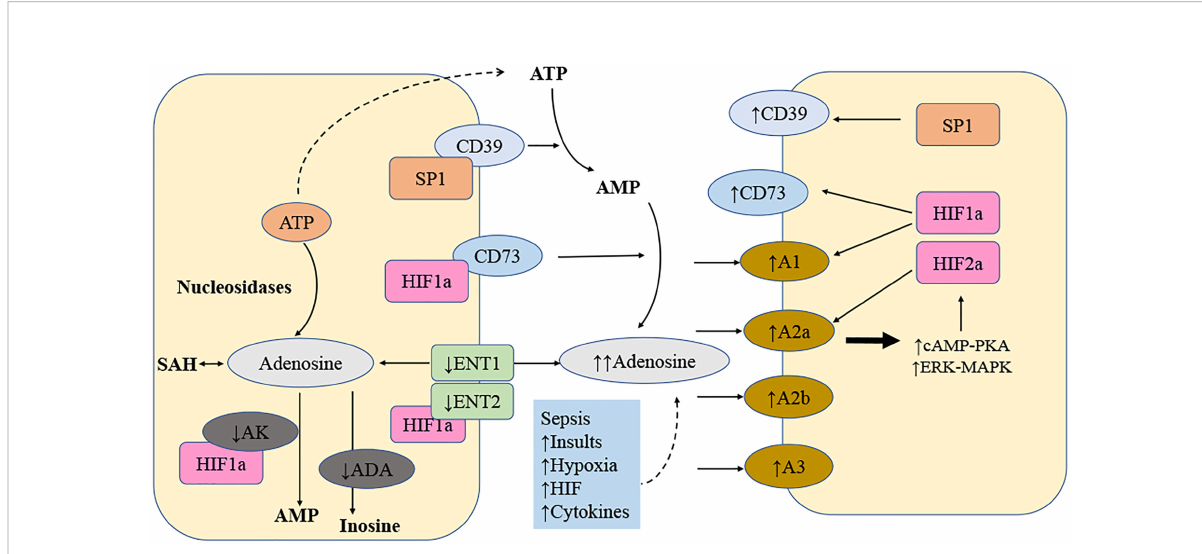
FIGURE 1 Local ampli fi cation of adenosine signaling in sepsis. The levels of extracellular adenosine is in fl uenced by several factors. Adenosine is transferred by a transporter called equilibrate nucleoside transporter 1 (ENT1) and many additional transporters. Numerous mechanisms result in the release of ATP. ATP is converted to adenosine by the combination of ectonucleoside triphosphate diphosphohydrolase 1 (ENTPD1; also known as CD39) and ecto5 ′ -nucleotidase (NT5E; also known as CD73). After that, adenosine could be converted to inosine, adenosine monophosphate (AMP), or S-adenosylhomocysteine (SAH). An increase in extracellular adenosine concentration from the baseline (20-300 nM) to up to 30 mM dramatically enhances sepsis-related adenosine signaling. Additionally, there is a strong simultaneous increase of enzymes involved in the metabolic process that degrade ATP into adenosine and inhibition of enzymes to degrade adenosine, for example, adenosine kinase (AK). The following variables regulate adenosine signaling in diseased conditions: more ATP released into extracellular space as precursor of adenosine; more ENTPD1 and NT5E expression; HIF2 induce more A2a receptor expression; HIF1 induce more A2b receptor expression; HIF1 inhibit AK, ENT1 and ENT2. ADA stands for adenosine deaminase; cAMP stands for cyclic AMP; ERK stands for extracellular signal-regulated kinase; MAPK stands for mitogen-activated protein kinase; and PKA is for protein kinase